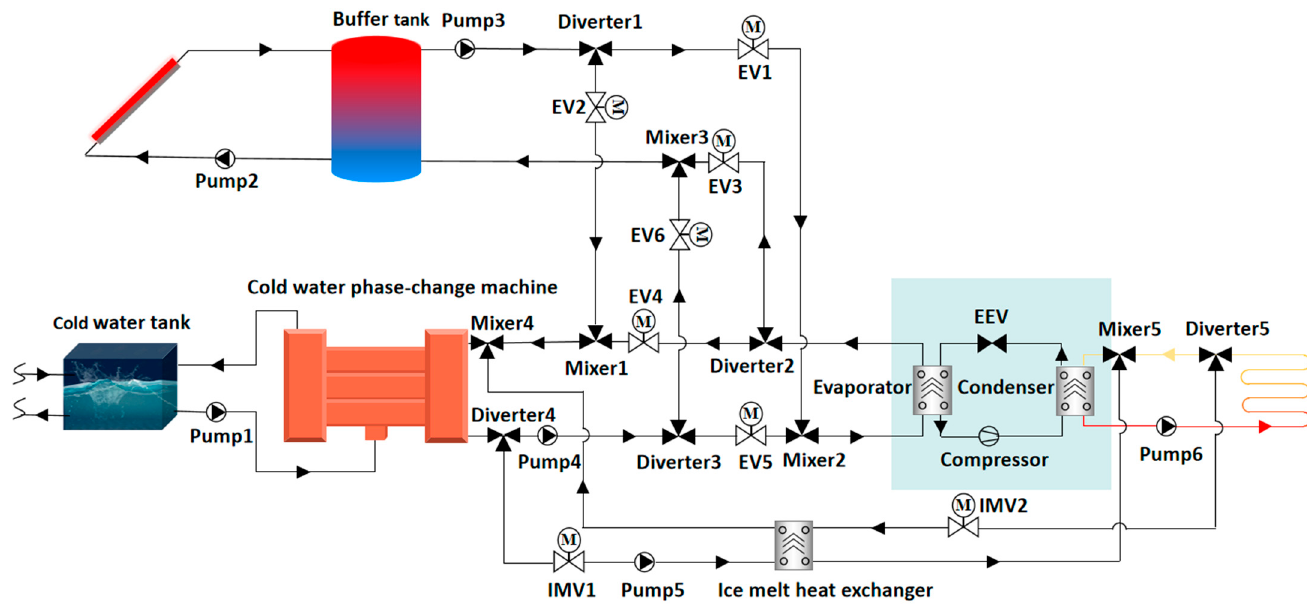
Figure 1. The operating principle of SAPCHPs.